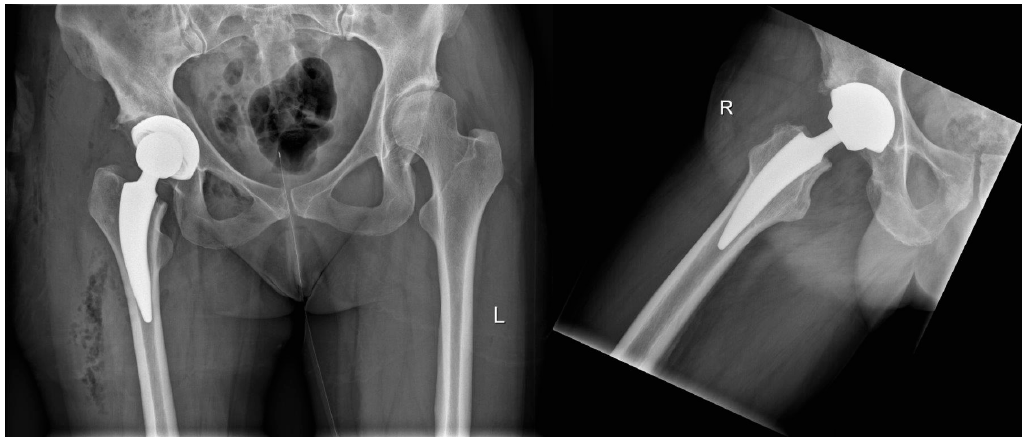
Figure 1. Immediate postoperative situation after MiniMIS implantation on the right site,